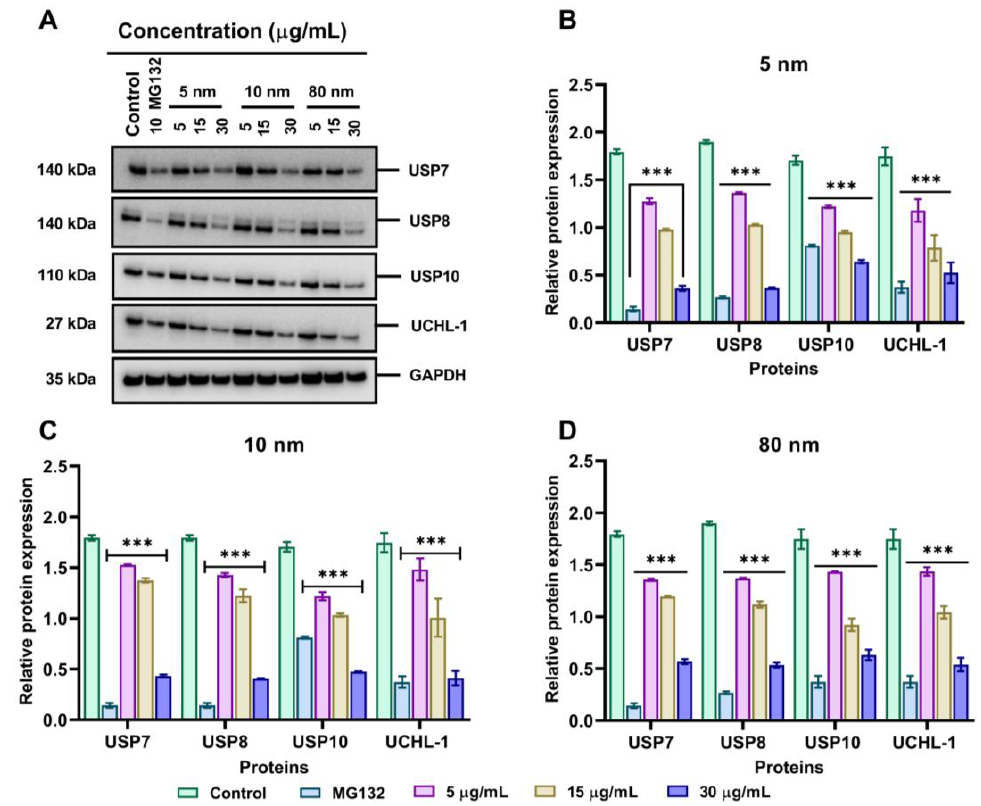
Figure 7. AuNPs downregulate the expression of DUBs in A549 cells. ( A ) Expression levels of DUBs detected by Western blot after A549 cells were incubated with 5, 15, and 30 µg/mL of different sizes of AuNPs for 24 h. MG132 (10 µg/mL) was used as a positive control. The relative protein expression signal intensity was semi-quantified by ImageJ software for ( B ) 5 nm, ( C ) 10 nm, and ( D ) 80 nm AuNPs. Plotted graphs represent the means ± SD of three independent experiments. Bars with an asterisk (*) show a statistical difference (*** p < 0.001) when compared with the control.